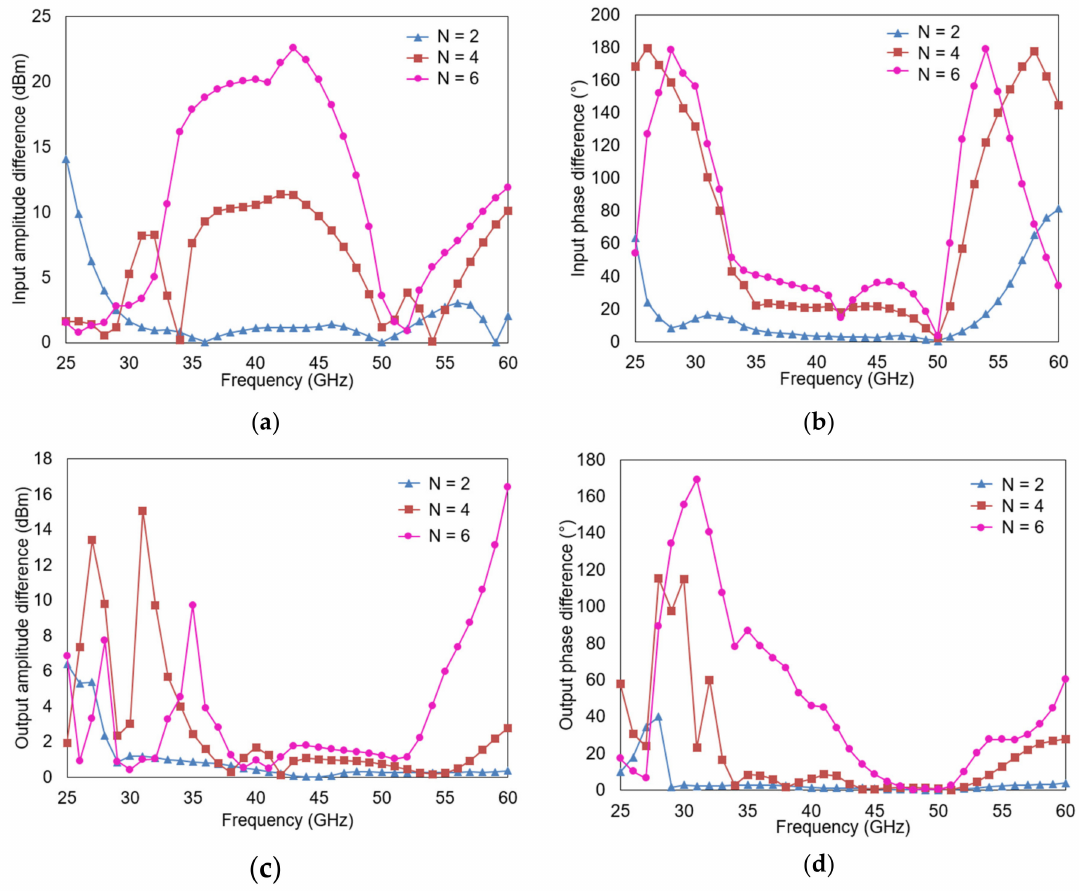
Figure 3. Simulated amplitude and phase di ff erences of the inputs and outputs between the first ZPS power cell and the last, according to the number of cells ( N ): ( a ) input amplitude di ff erence ( b ) input phase di ff erence ( c ) output amplitude di ff erence ( d ) output phase di ff